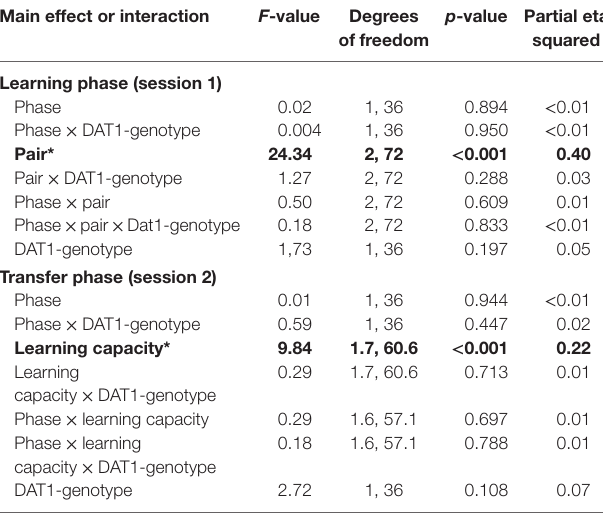
*Effects that are significant at p < 0.05 are highlighted in bold and are marked with an asterisk. If required violations of sphericity were corrected with